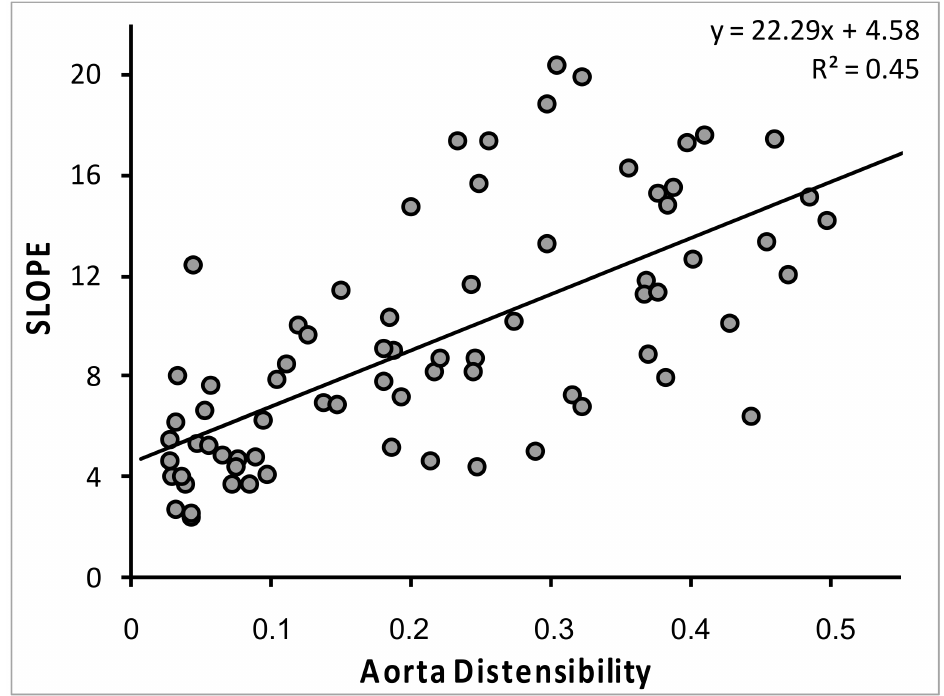
Figure 5. Univariate linear relationship between the slope of the cross-section carotid diameter- pressure curves and aorta distensibility [1/(carotid–femoral PWV) 2